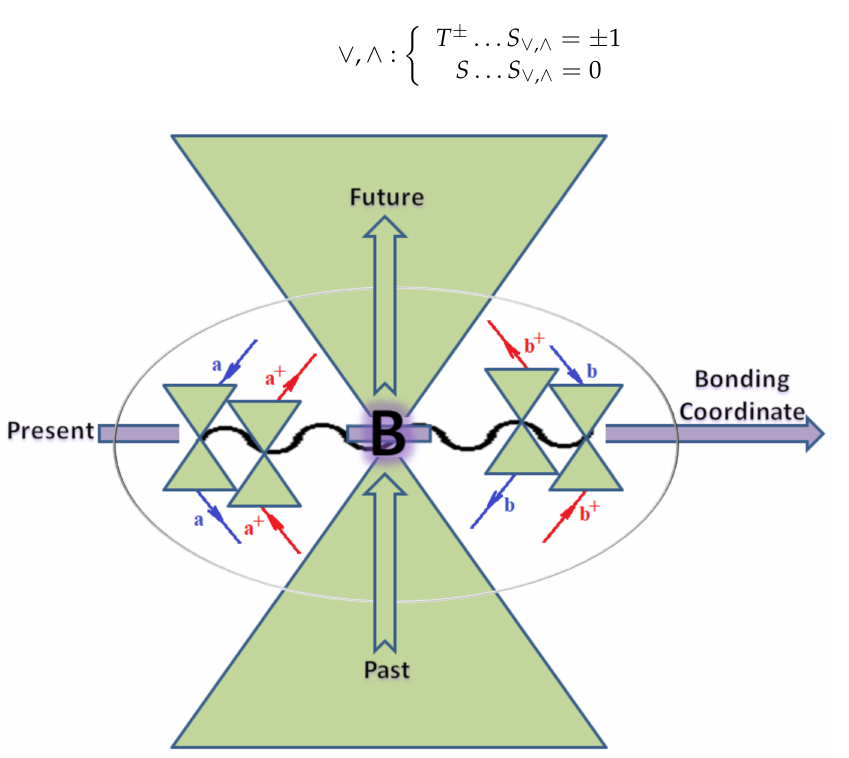
Figure 1. The Feynman’s bondonic prototype from creation and annihilation quantum operators; the resulting basic life-lines of electronic quantum dynamics structures include the following, from left to right: nucleophilic (active hole), electrophilic (active electron, conduction, ionization), radicalic affinity (active hole–electronic pair), and protonation (electronic annihilation in situ)—bosonizations, respectively. Basically, the entire chemical bonding and reactivity phenomenology can be described with the resulting “bondonic–zoo”; the respective classification, according to the relativistic-coupled (past-in and future-in bonding) spinning sectors of specific bondons, are in Table 1, systematically detailed—also see the text for further